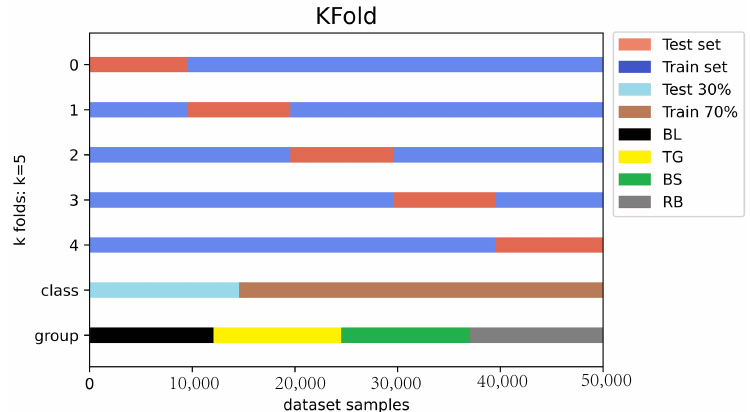
Table 4. K-fold cross validation classification accuracy (%) of the four model methods. Dataset (k = 5) Gan- faster-rcnn Standard faster-rcnn